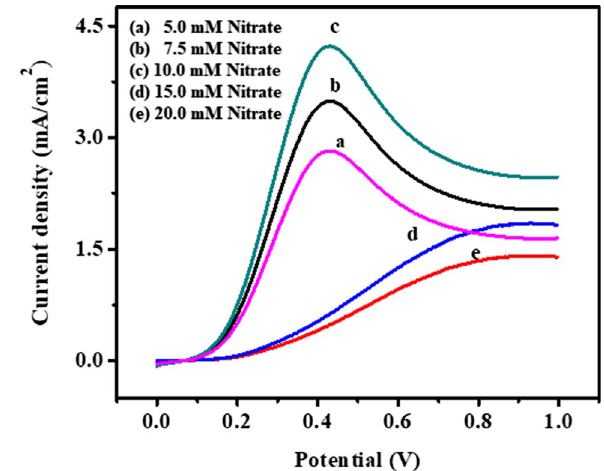
Fig. 9 LSVs of the GCE/RGO/PPy/NR-modified GC electrode in